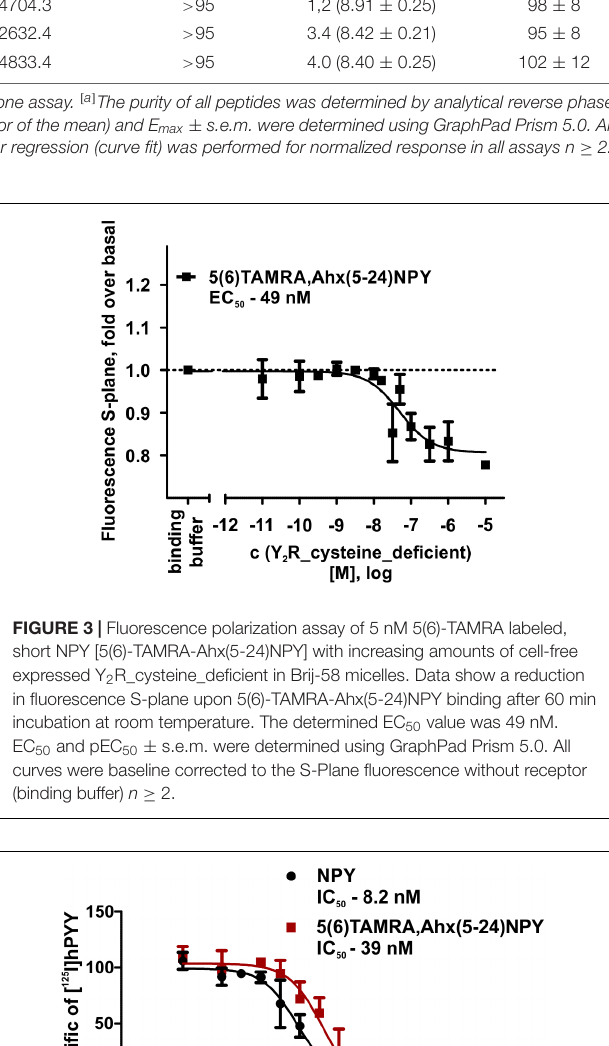
calculated using GraphPad Prism 5.0 non-linear regression (curve fit) n ≥